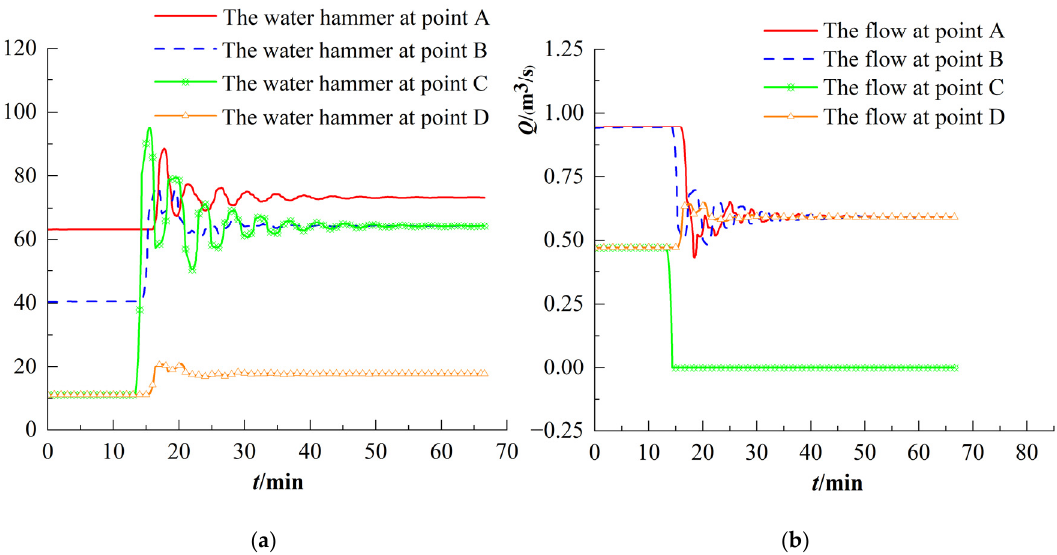
Figure 10. The flow and pressure head variations at different locations when the valve is closed only at C. ( a ) The water hammer changes with time at different positions. ( b ) Flow at different locations varies with time.